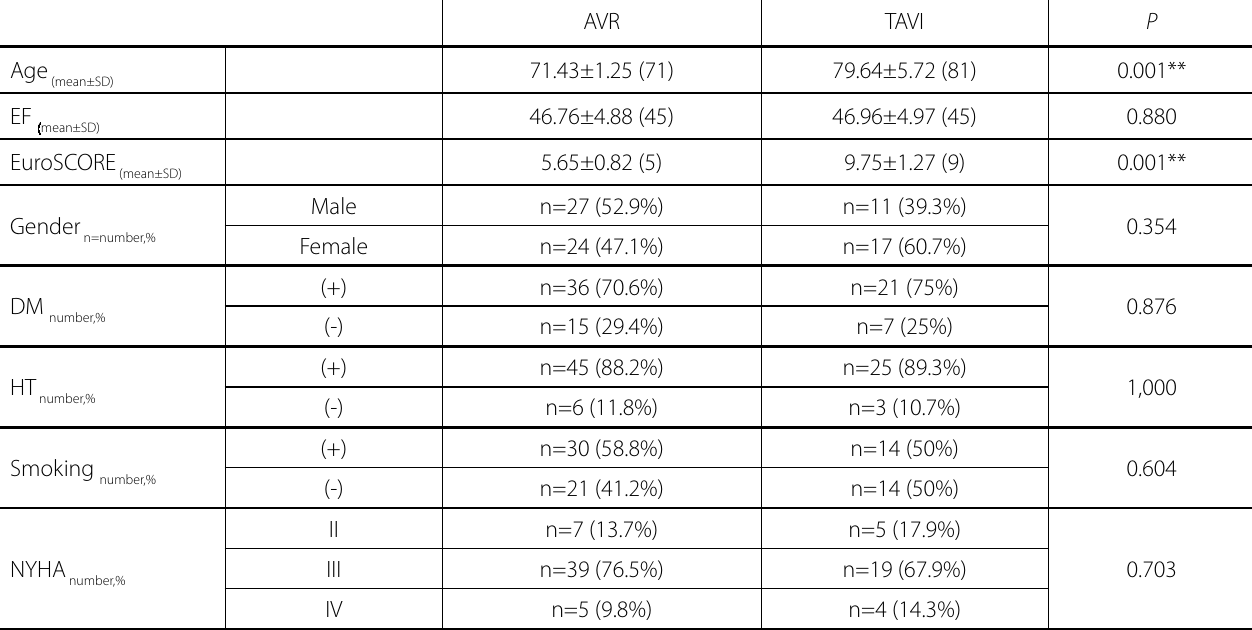
Table 1. Patients’ demographic and clinical data according to groups.